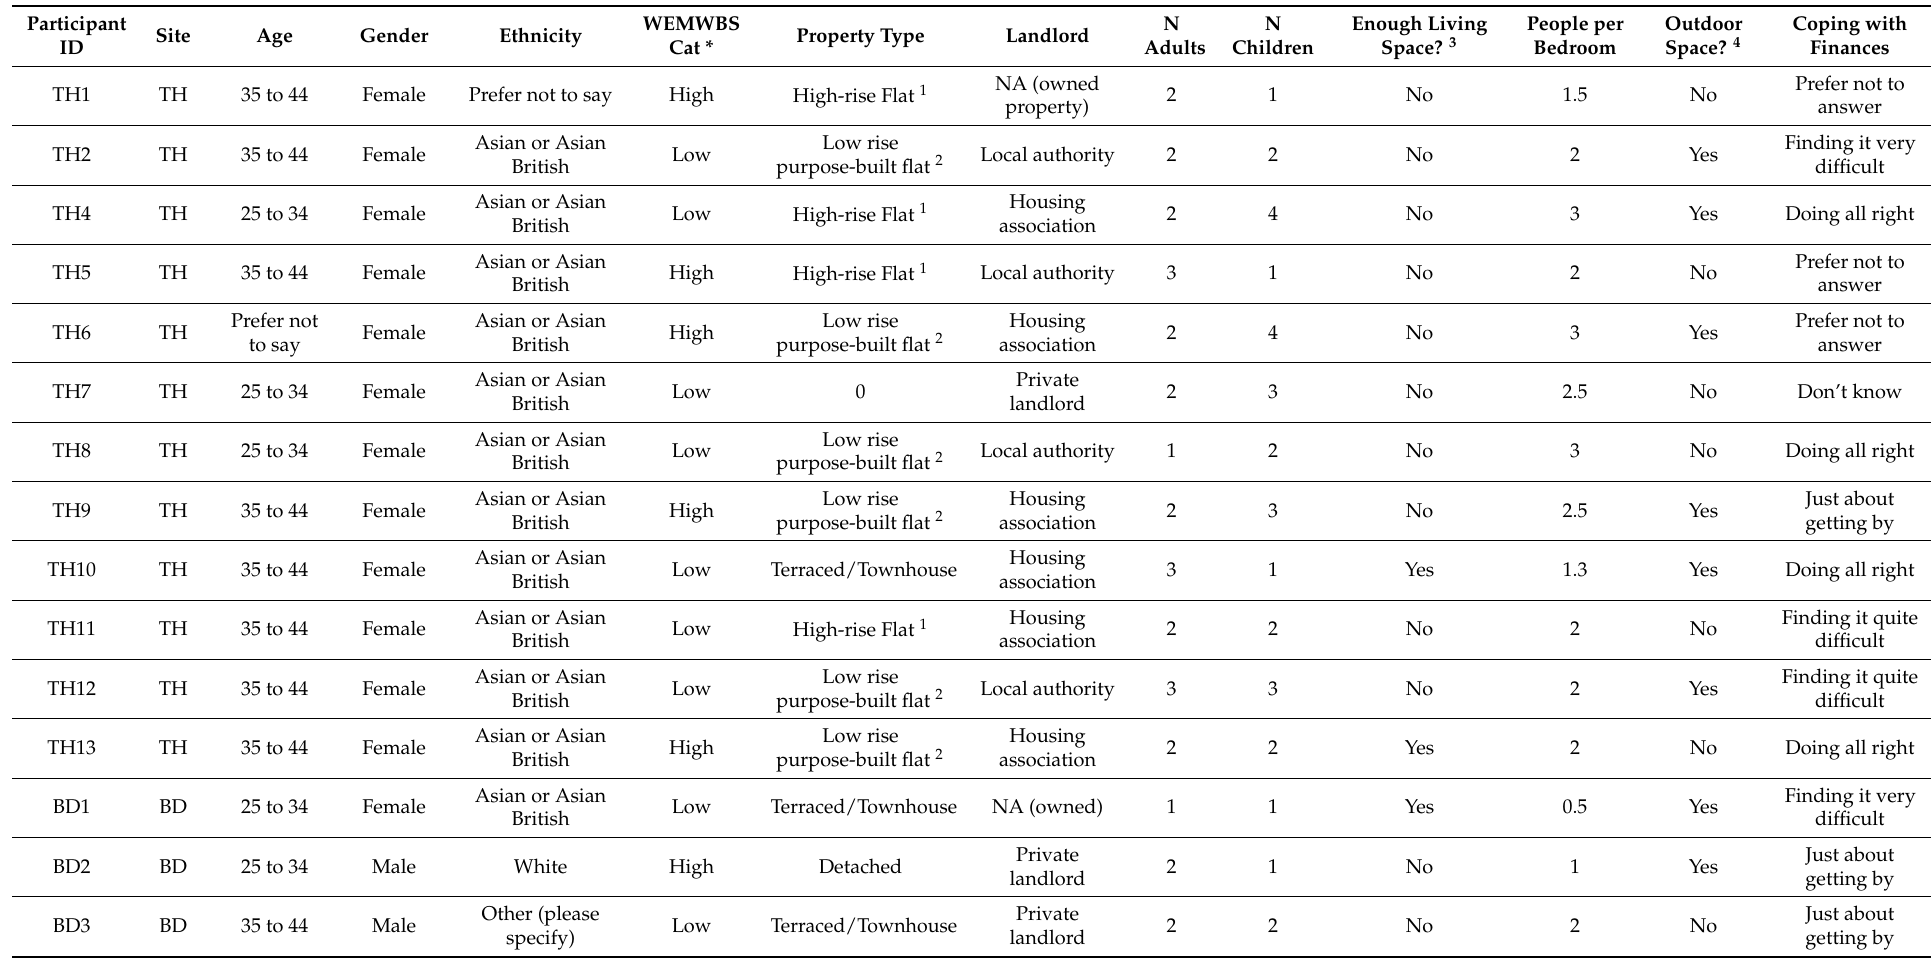
Table 1. Participant self-reported demographics, wellbeing score (adults), accommodation details and coping with finances (data from fully completed question- naires